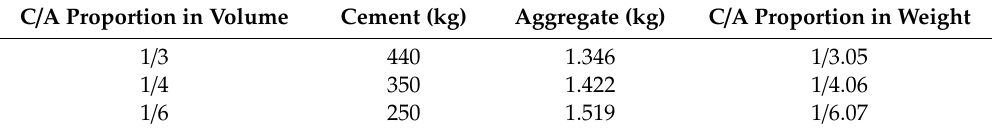
Table 5. Volume and weight dosages of cement and aggregate in mortars.